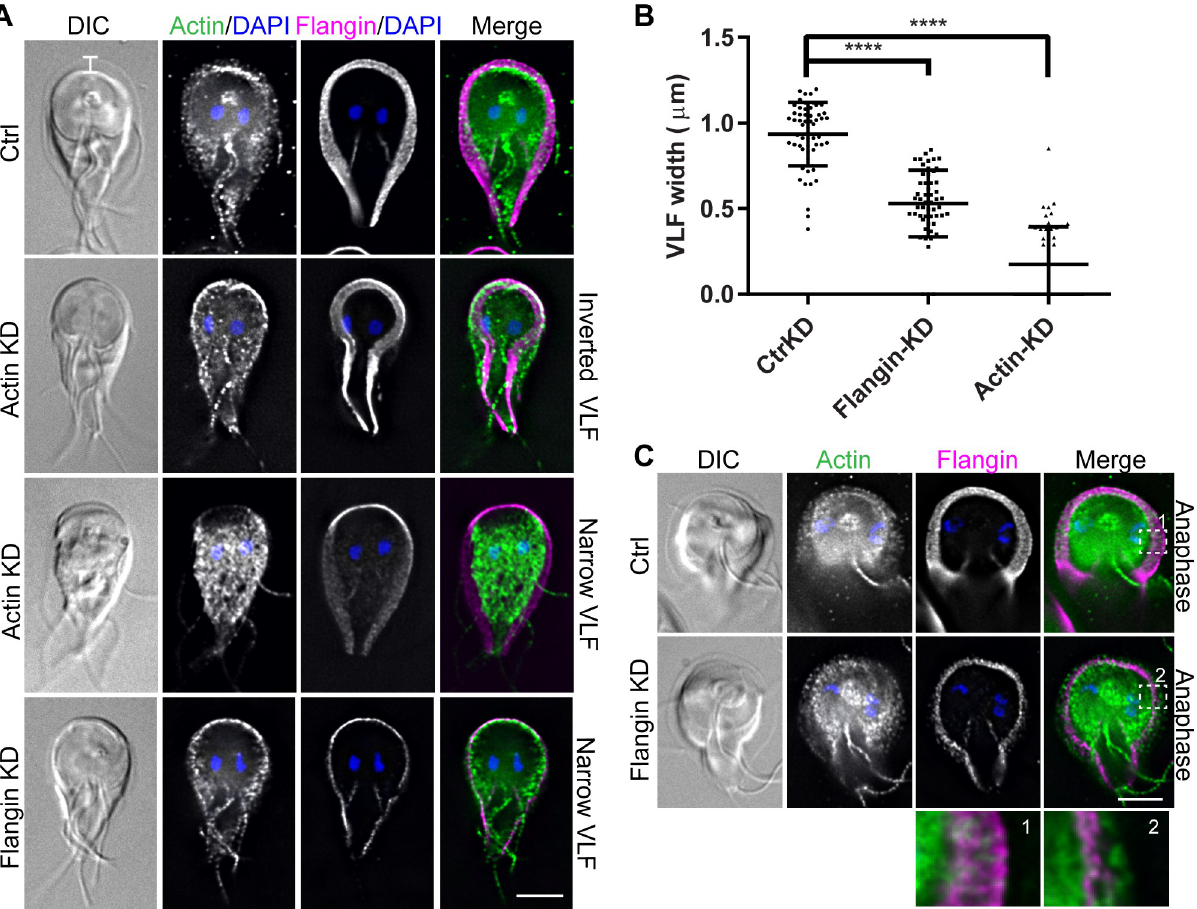
Fig 2. Flangin and Gl Actin are necessary for flange assembly. (A) Trophozoites were stained for Gl Actin (green), Flangin-HA (magenta), and DNA (blue). Note that images are scaled to display the remaining protein and are not intended to show differences in protein levels. Gl Actin knockdown (KD) resulted in inverted and collapsed flange morphology. Flangin-HA KD similarly resulted in a thin flange phenotype. (B) Quantification of flange width when measured at the cell anterior from three independent experiments; control (n = 57), Flangin-HA (n = 54), and actin (n = 51). Statistical significance was evaluated for Flangin-KD and Actin-KD respectively, t test. ���� , P < 0.0001. (C) Mitotic Flangin depleted cells were capable of extending their flange beyond the leading edge of Flangin. The insets show actin beyond the leading edge of Flangin-HA in Flangin-HA KD cells during mitotic flange extension. Scale bars = 5 μ